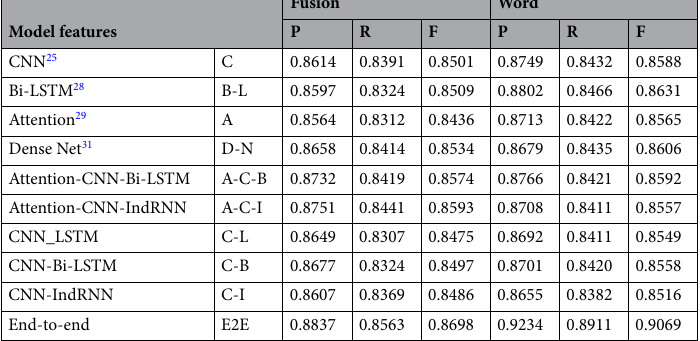
Table 7. Effect of different deep learning models on the evaluation criteria values for UAV images.